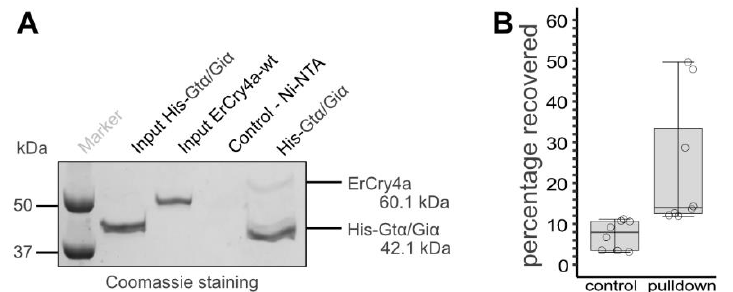
Figure 2. Pulldown experiments of Er Cry4a and the His-tagged G t α/Giα chimera. ( A ) SDS-PAGE gel of a representative pulldown experiment employing purified proteins to investigate if Er Cry4a interacts with the His-tagged G t α/Giα chimera. Input lanes show the proteins used for the pulldown expe riment. As a negative control, only Er Cry4a, but no His-tagged G t α/Giα chimera, was incubated with a Ni -NTA affinity matrix. For the experiment, a pre-incubated mixture of both proteins was incubated with the matrix. The full size of the gel image is provided in the supplement (Figure S6). ( B ) Densitometry analysis of eight pulldown experiments were carried out. Bars correspond to the average percentage of Er Cry4a recovered after the pulldown with error bars, individual results are marked by circles.